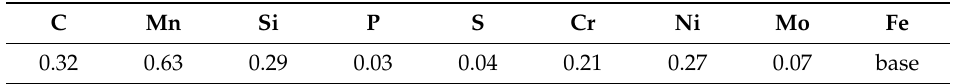
Table 1. Chemical composition of C30 steel used in study